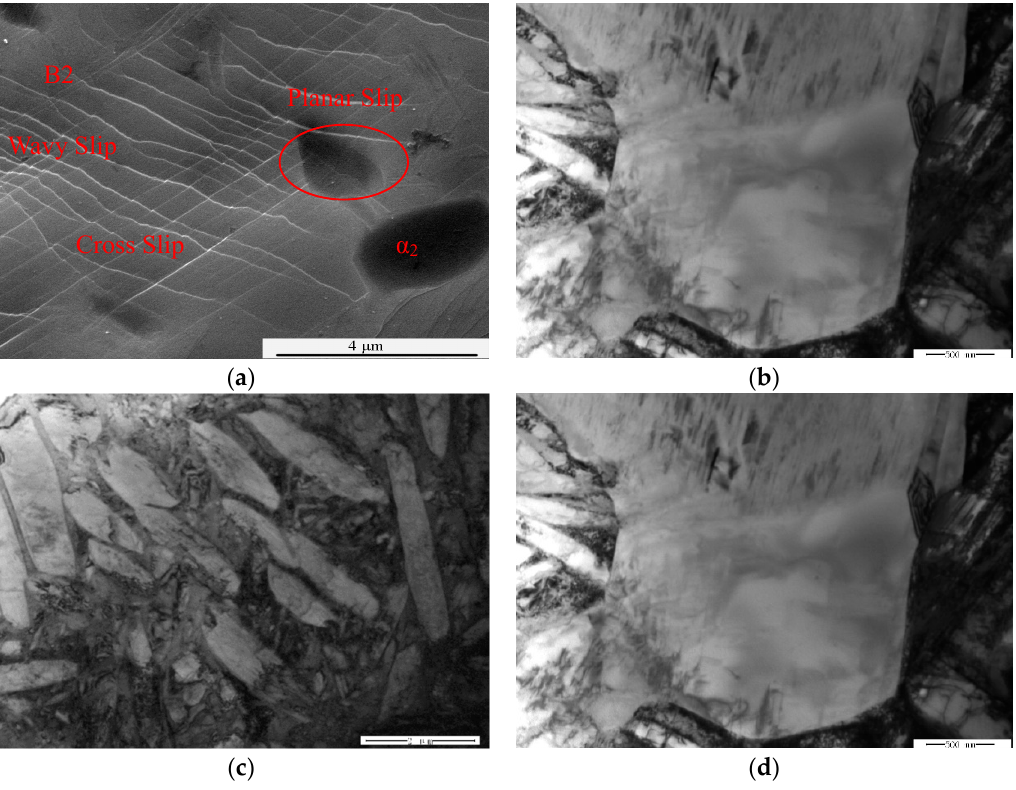
Figure 4. ( a ) Surface slip lines of the deformation area in tensile sample; ( b ) Equiaxed particles in undeformed zone of tensile sample; ( c ) the dislocation morphology of lamellar and equaxied α 2 particles in deformed zone of tensile sample; ( d ) slip band in equaxied α 2 particles in deformed zone of tensile sample.